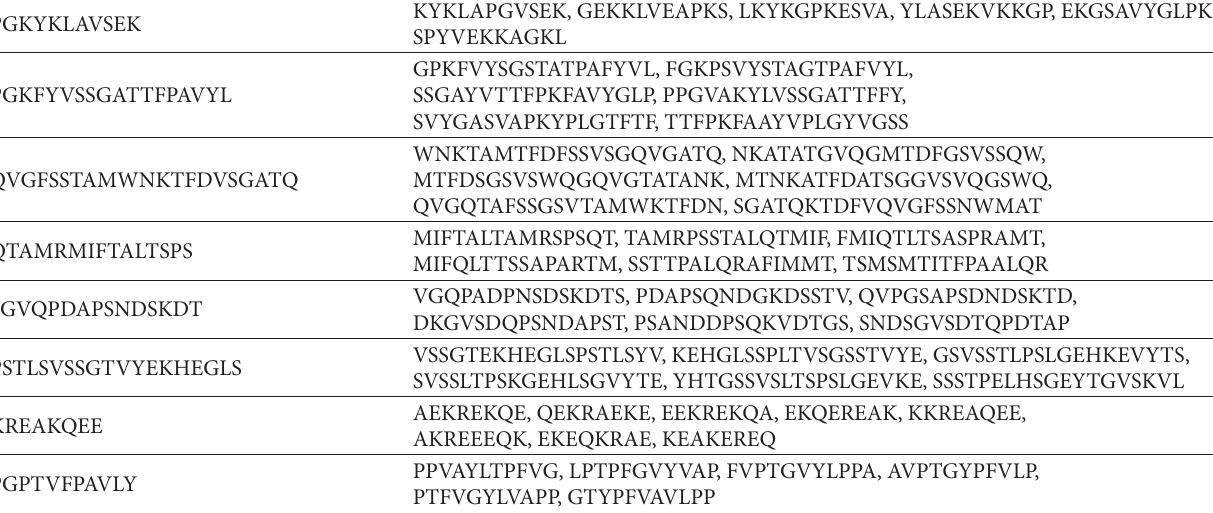
Table 3: Shuffled amino acid residues from